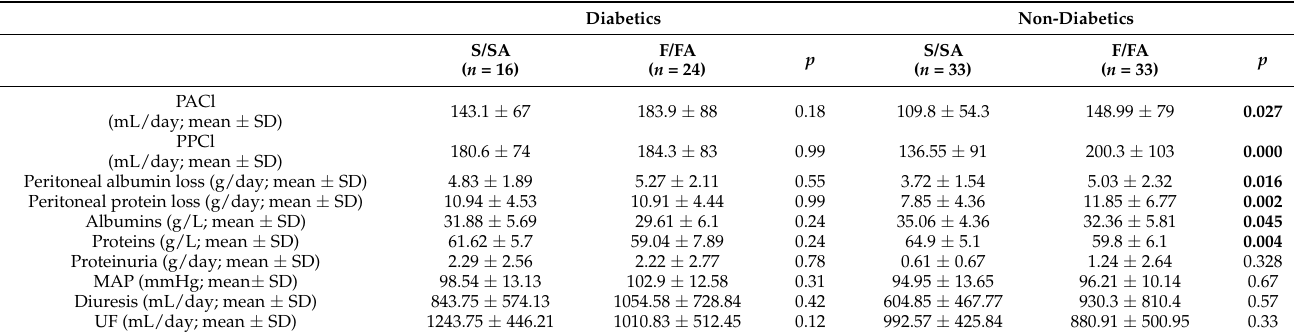
Table 2. Differences in investigated laboratory values between diabetics and non-diabetics according to peritoneal transport characteristics for creatinine. Diabetics Non-Diabetics S/SA ( n =